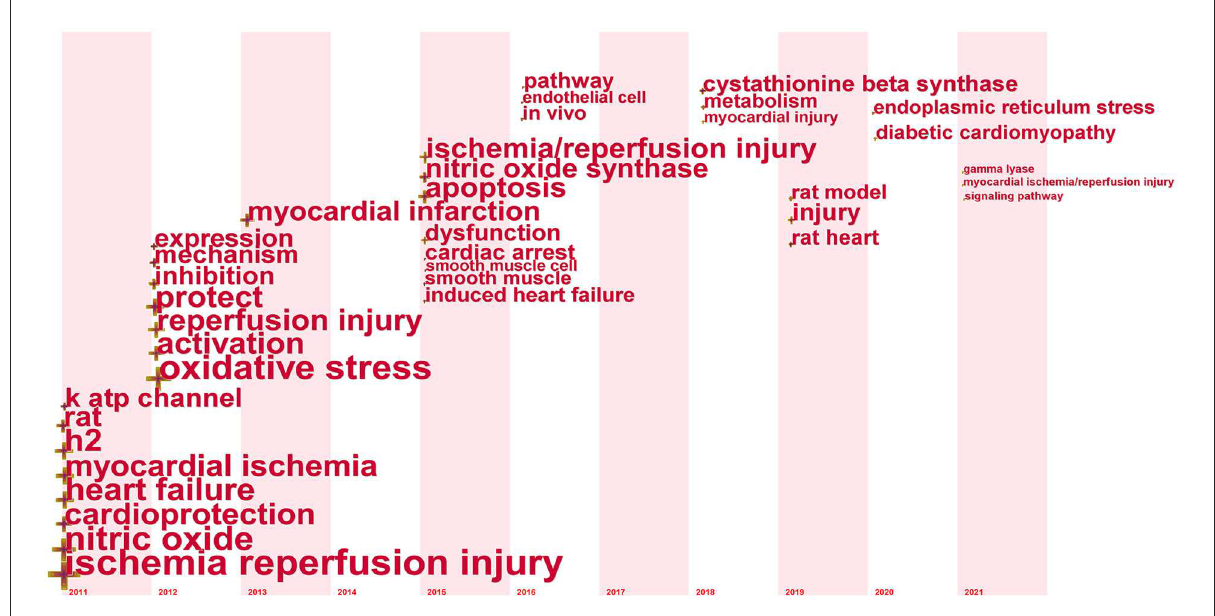
FIGURE7 CiteSpace overlay visualization of the keyword evolvement by